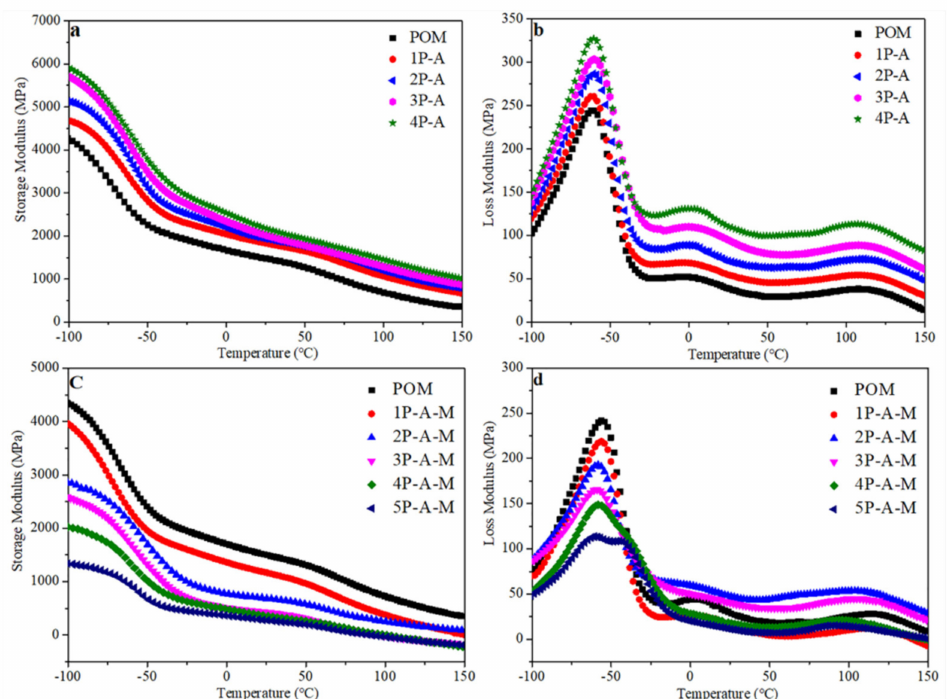
Figure 8. ( a )Storage modulus diagrams and ( b ) loss modulus diagrams of POM/Ag nanocom- posites; ( c ) storage modulus diagrams and ( d ) loss modulus diagrams of POM/Ag/MAH- g -POE ternary